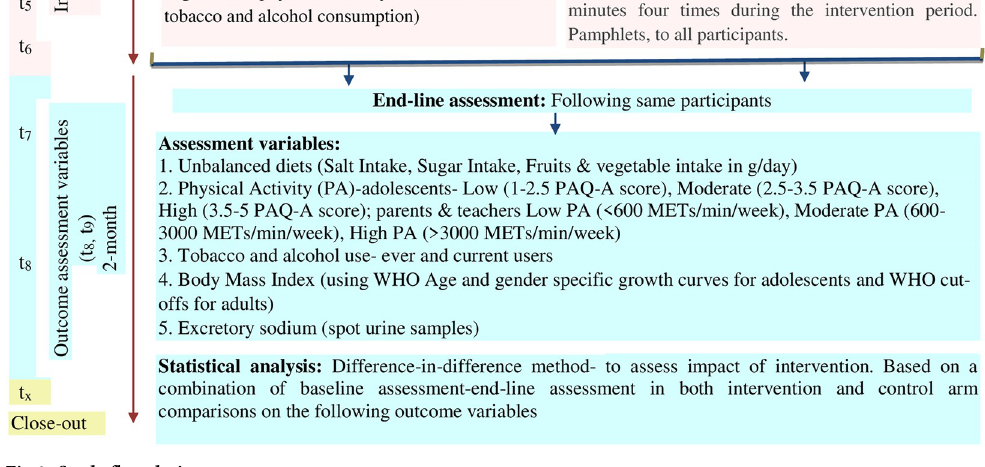
Fig 1. Study flow